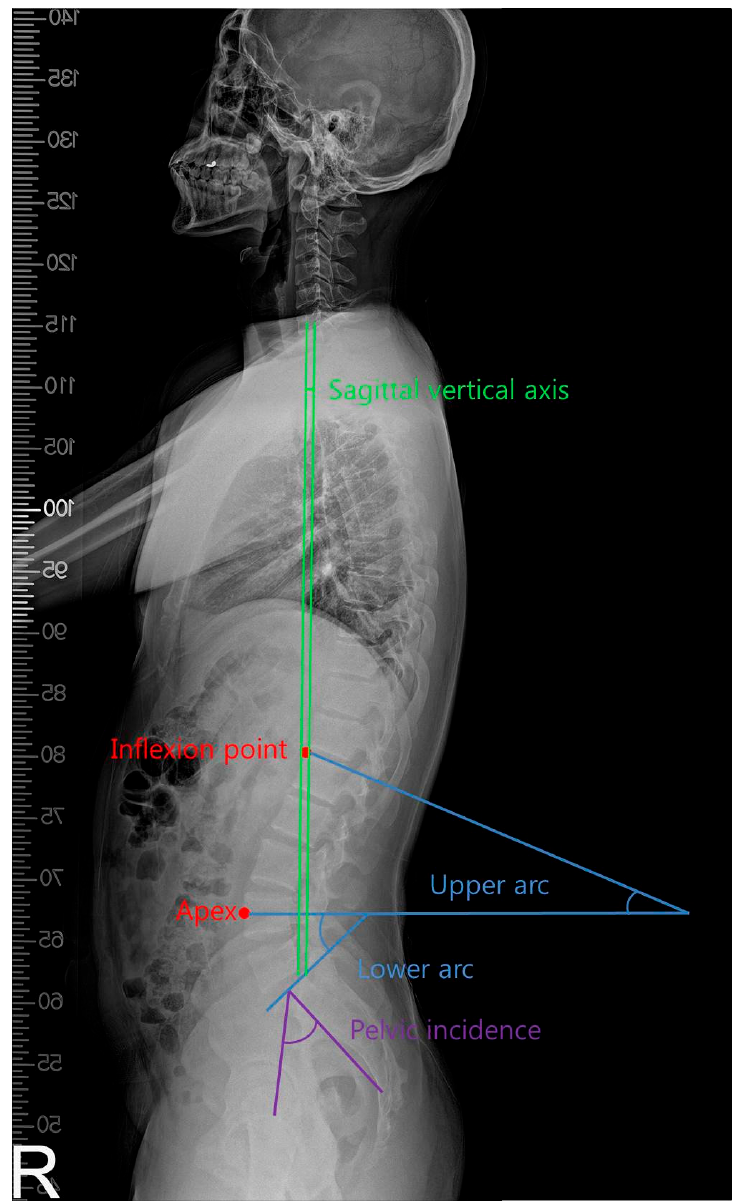
Figure 3. Measurement of the sagittal spinal alignment.